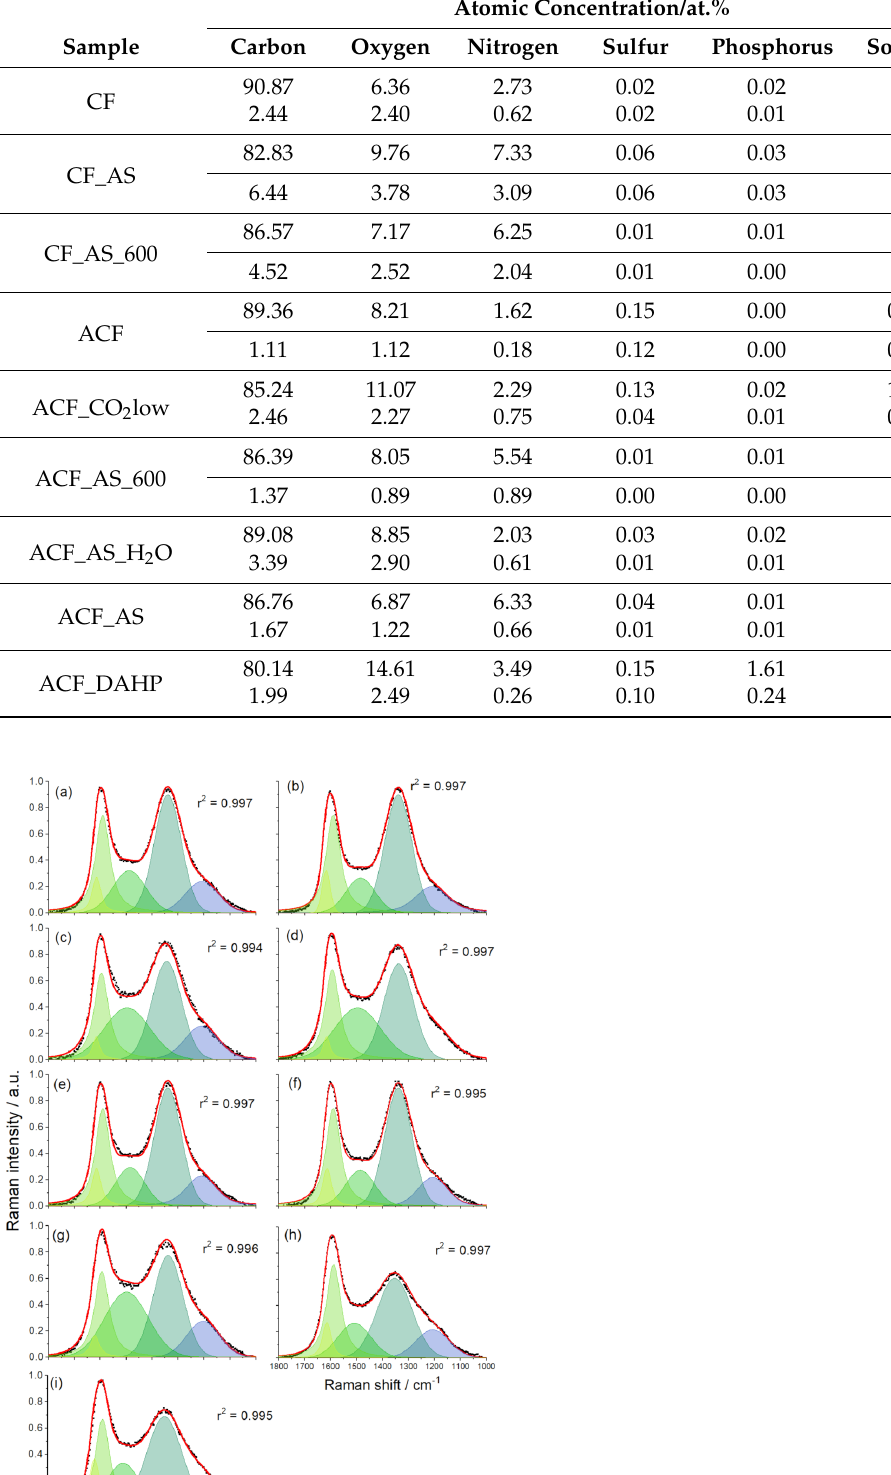
Table 3. The elemental composition obtained using EDX analysis (first row: atomic concentration in %, second row: standard deviation over four spots investigated for each sample).